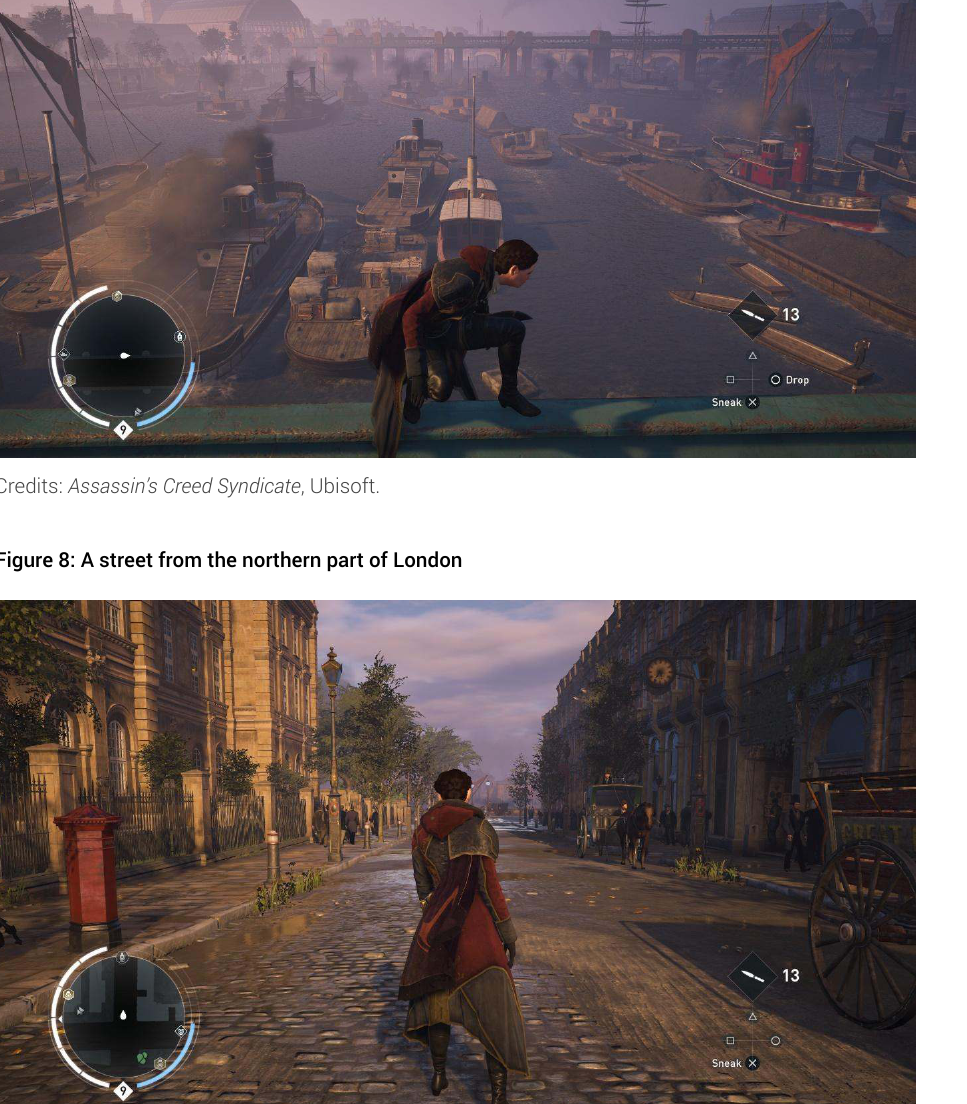
Credits: Assassin’s Creed Syndicate ,